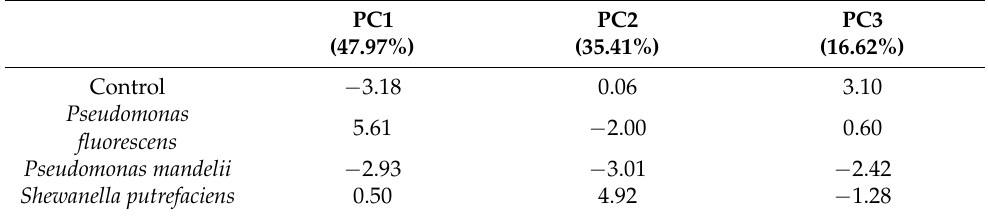
Table 2. Component scores on volatile compounds of sturgeon inoculated different SSOs,